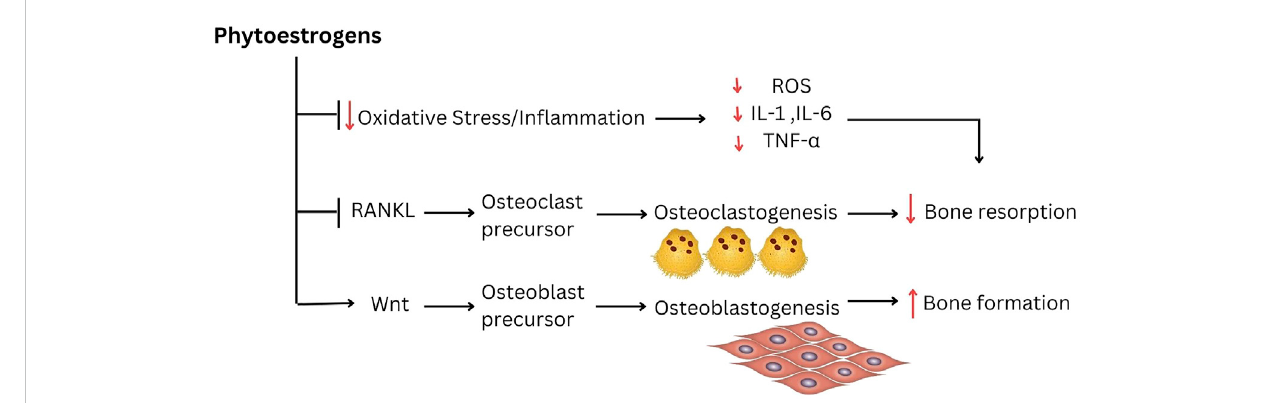
FIGURE 2 The possible molecular mechanism underlying the protection against alveolar bone loss by